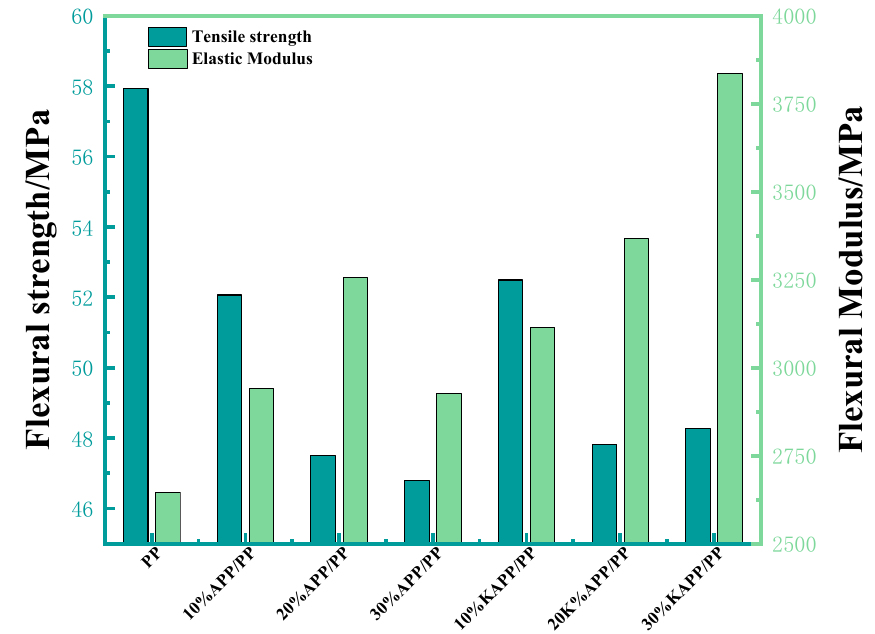
Figure 10. Mechanical properties of flame-retardant PP composite.